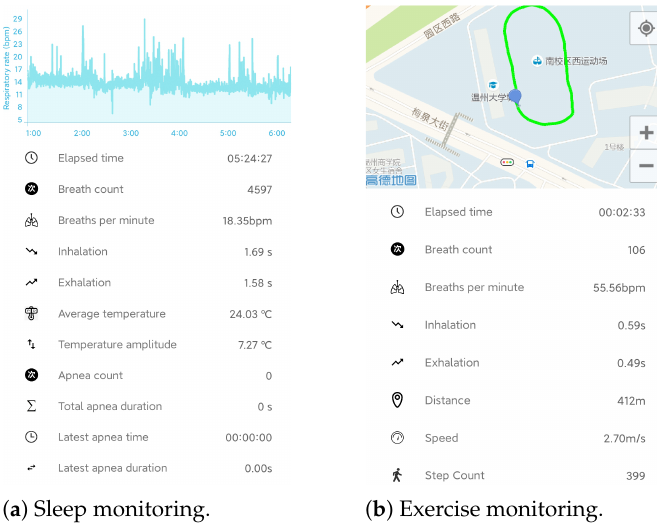
Figure 10. The Android APP for real time respiration